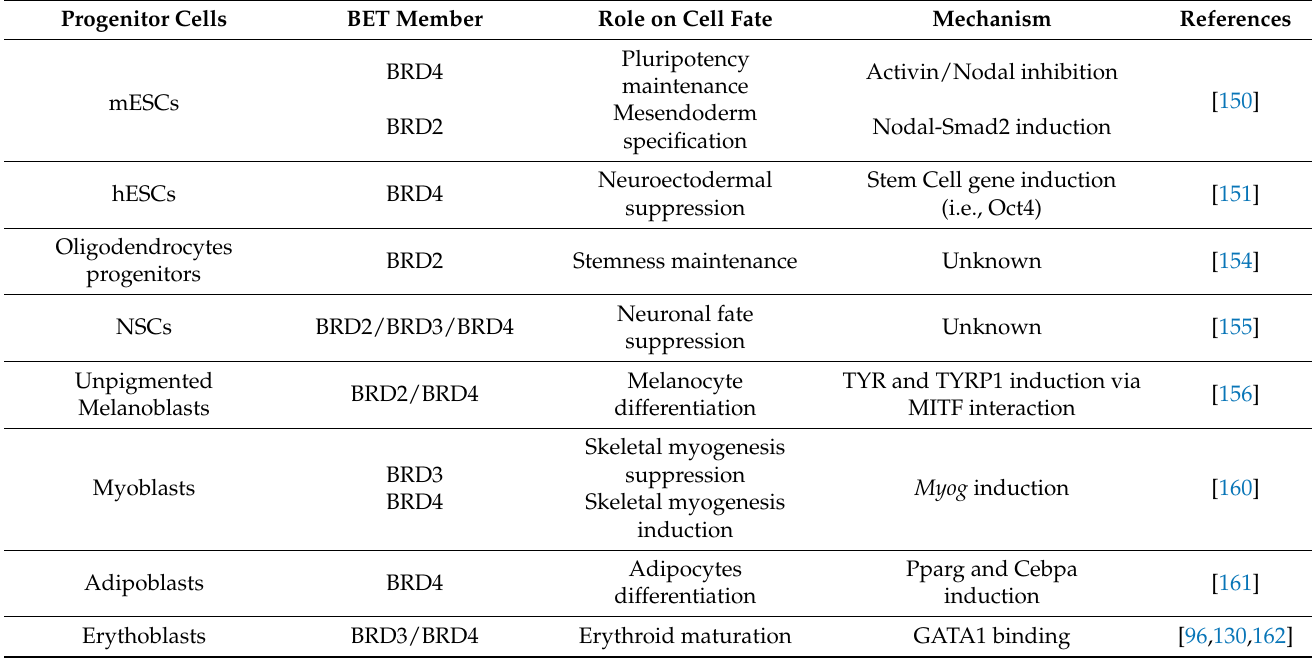
Table 1. BET proteins involvement in Cell